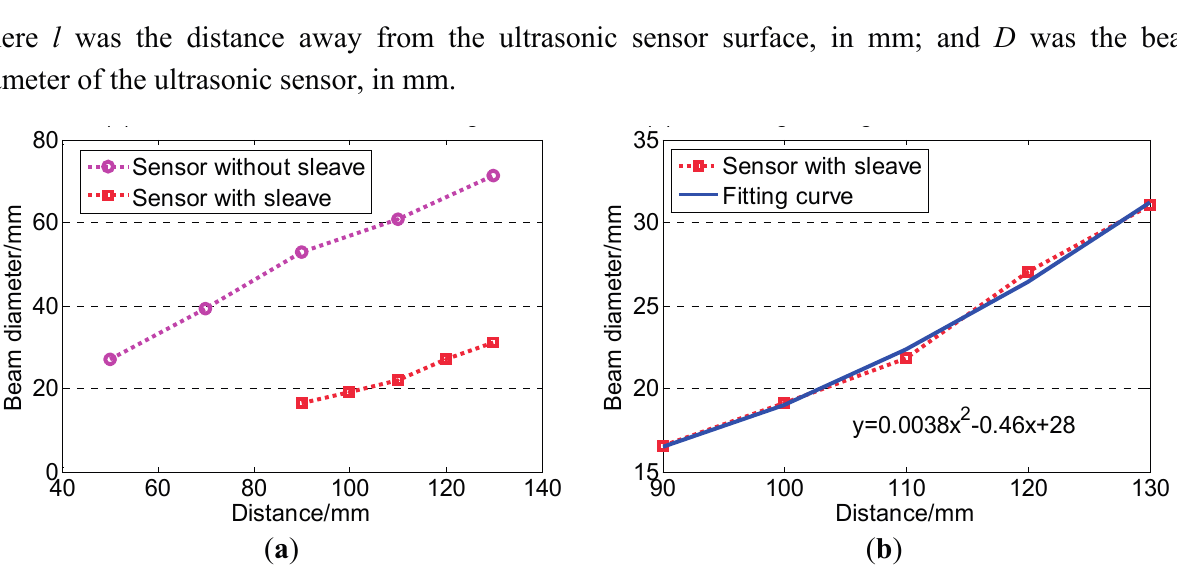
Figure 6. Beam diameter of the ultrasonic sensor changes because of the sleeve. ( a ) Sensor sleeve affects beam angle; ( b ) Beam angle fitting curve of sensor with